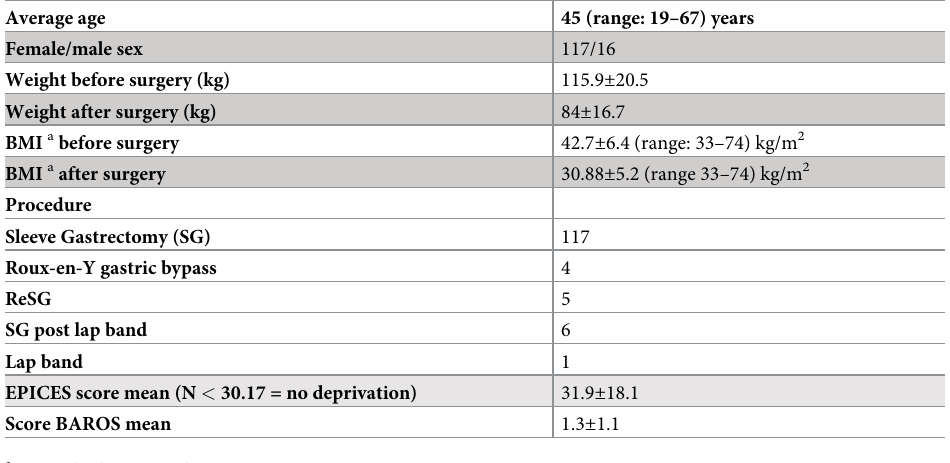
Table 1. Preoperative baseline characteristics of the population (n = 133).